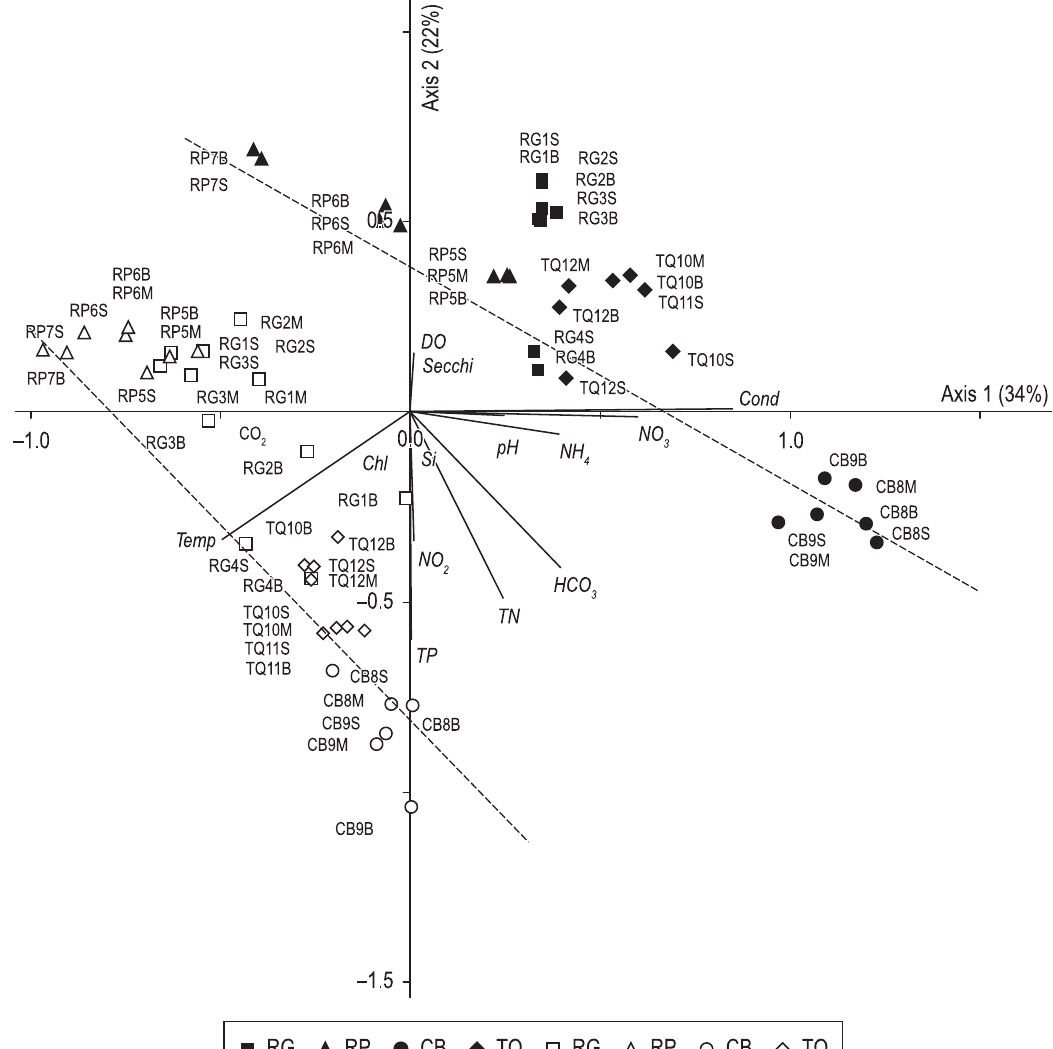
Figure 4. PCA biplot of limnological variables and scores for the sampling sites during the winter (solid symbols) and summer (open symbols). RG: Rio Grande Reservoir, RP: Rio Pequeno branch, CB: Central body, TQ: Taquacetuba branch; S: water surface, M: mean depth, B: 1 m above sediment. For correlation of variables with principal com- ponents and respective codes see Table